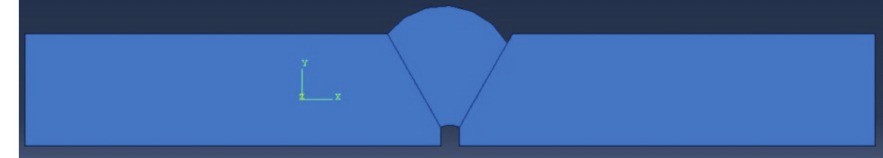
Figure 2. Model with excess weld metal, incomplete root penetration, and undercut.